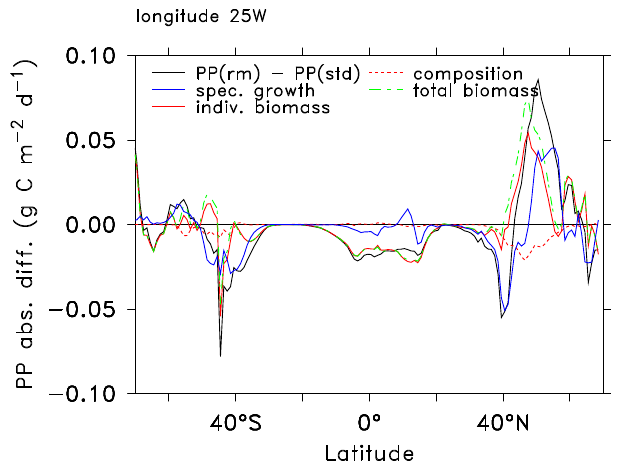
Figure 3. Absolute primary production (PP) changes (black; cf. Fig. 2e) due to the reduction in mixing, and decomposition into ef- fects of total biomass, growth rate, or composition changes along 25 ◦ W. The mixing reduction affects the specific growth rate (red) via nutrient and light conditions as well as the individual biomass of phytoplankton subtypes via effects on both total biomass and com- munity composition (solid blue). Effects on the individual biomass arise from changes in total biomass (dashed light blue) and shifts in community composition, i.e. the relative biomass of each phyto- plankton subtype (dashed dark blue). Displayed are zonal averages from the simulation with n = 78 subtypes. See the appendix for de- tails on the